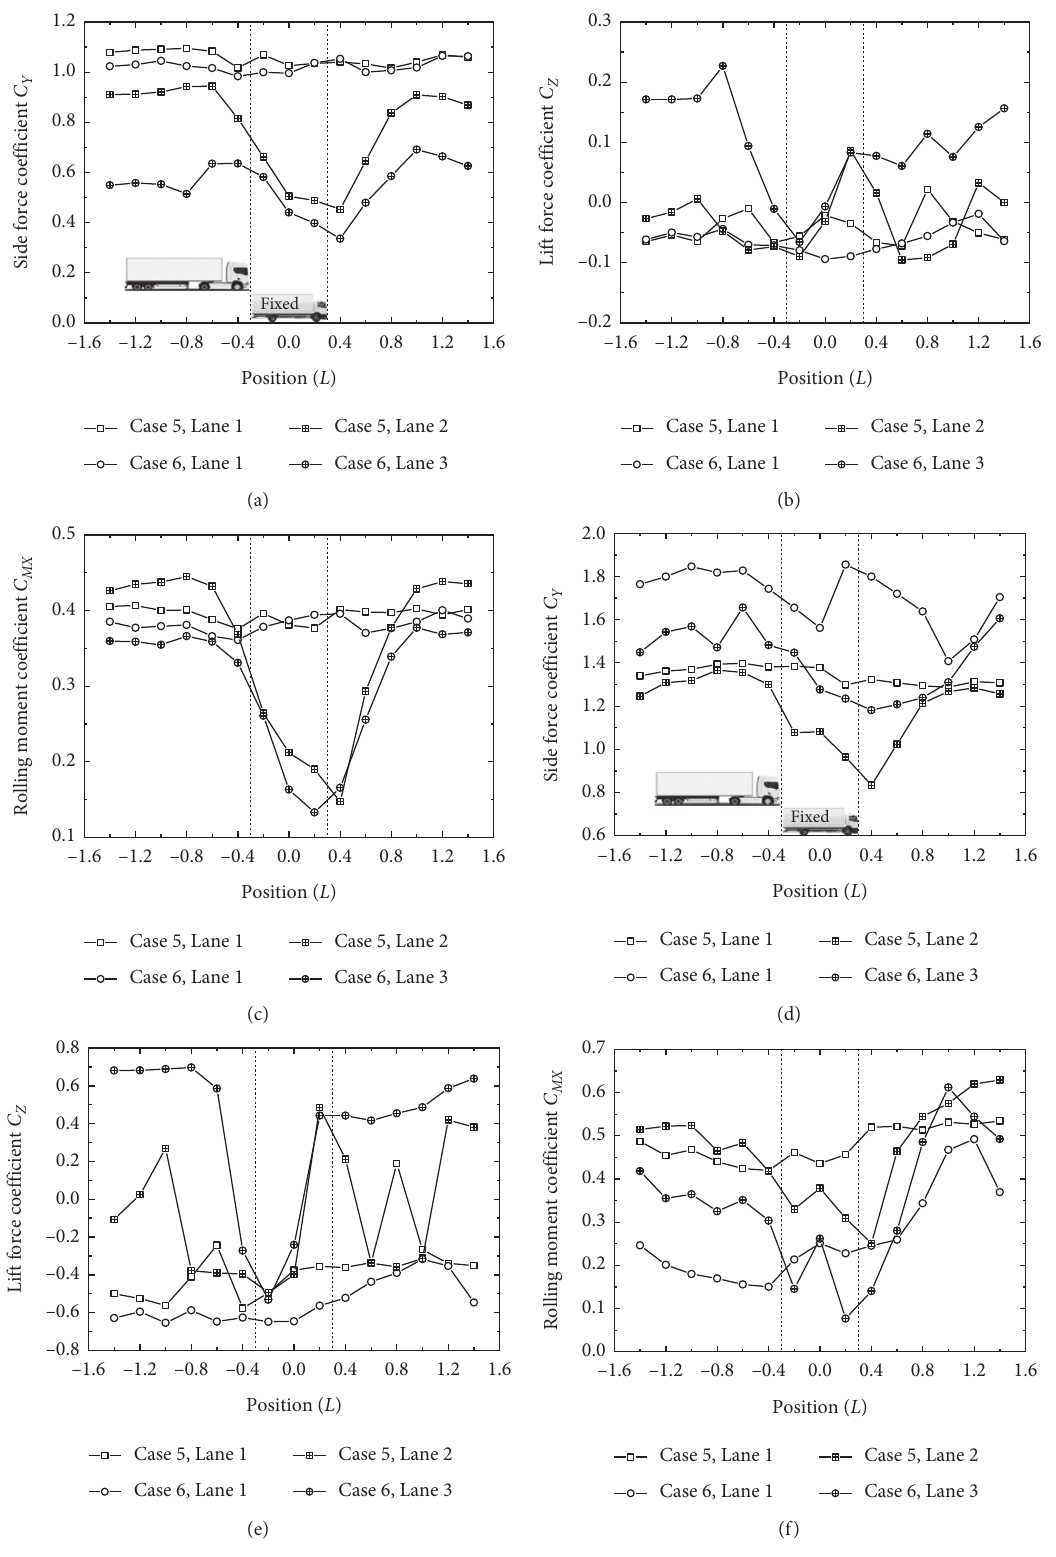
Figure 8: Aerodynamic coefficient of the lorry affected by van ((a), (b), (c) mean; (d), (e), (f) 3 s